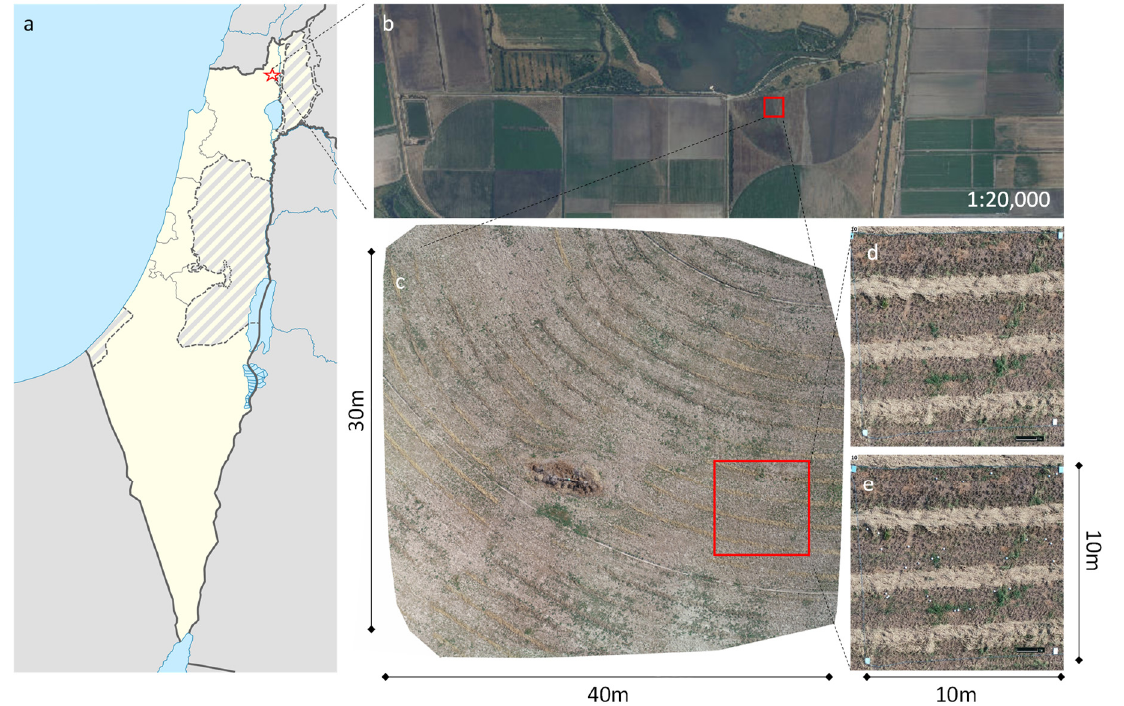
Figure 2. Field study area, ( a ) the general location; ( b ) aerial orthophotograph (photographic scale 1:20,000) of the Alfalfa fields (national database delivered by Ofek Aerial Photography LTD published on www.govmap.gov.il, accessed on 17 July 2021); ( c ) UAS-based orthophoto map of a selected area (30 × 40 m); ( d ) a selected plot area marked by four rectangle ground targets in the corners; ( e ) the same plot as in c after marking burrows with white Styrofoam balls.